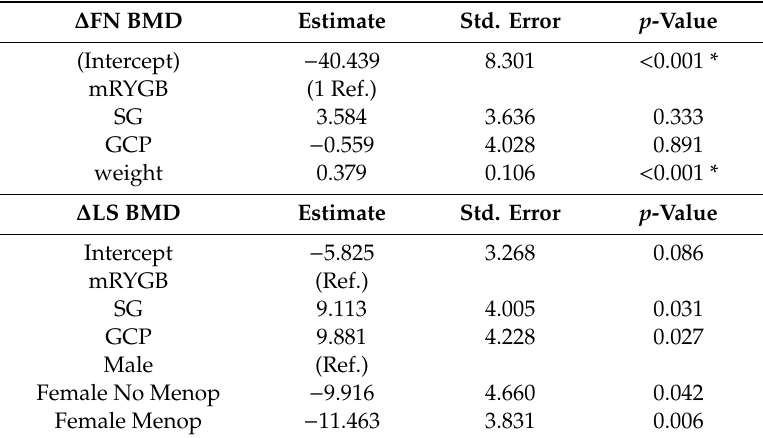
Table 4. Coe ffi cients of the regression